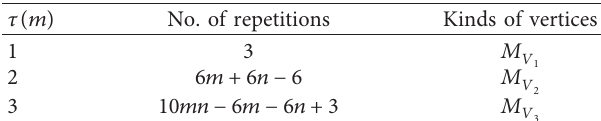
− II [ m, n ] established on degrees C 2 3